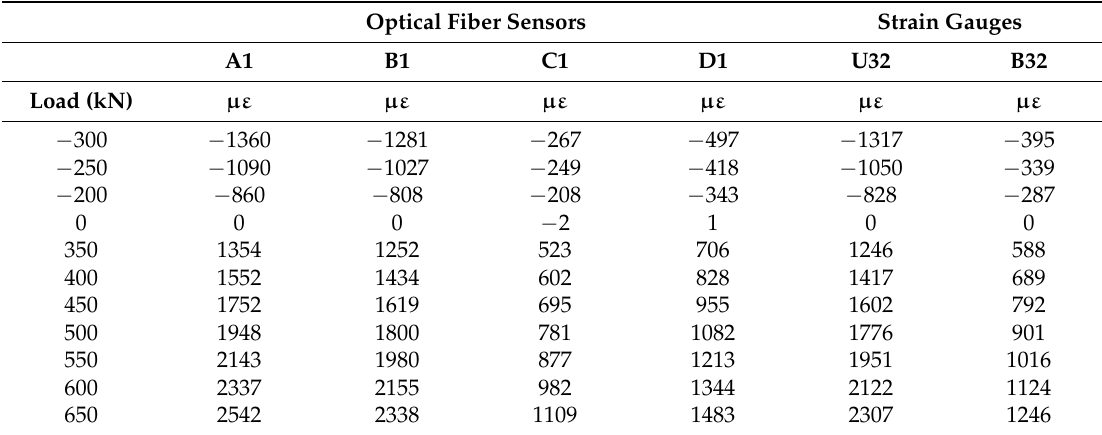
Table 2. Limit Load Test